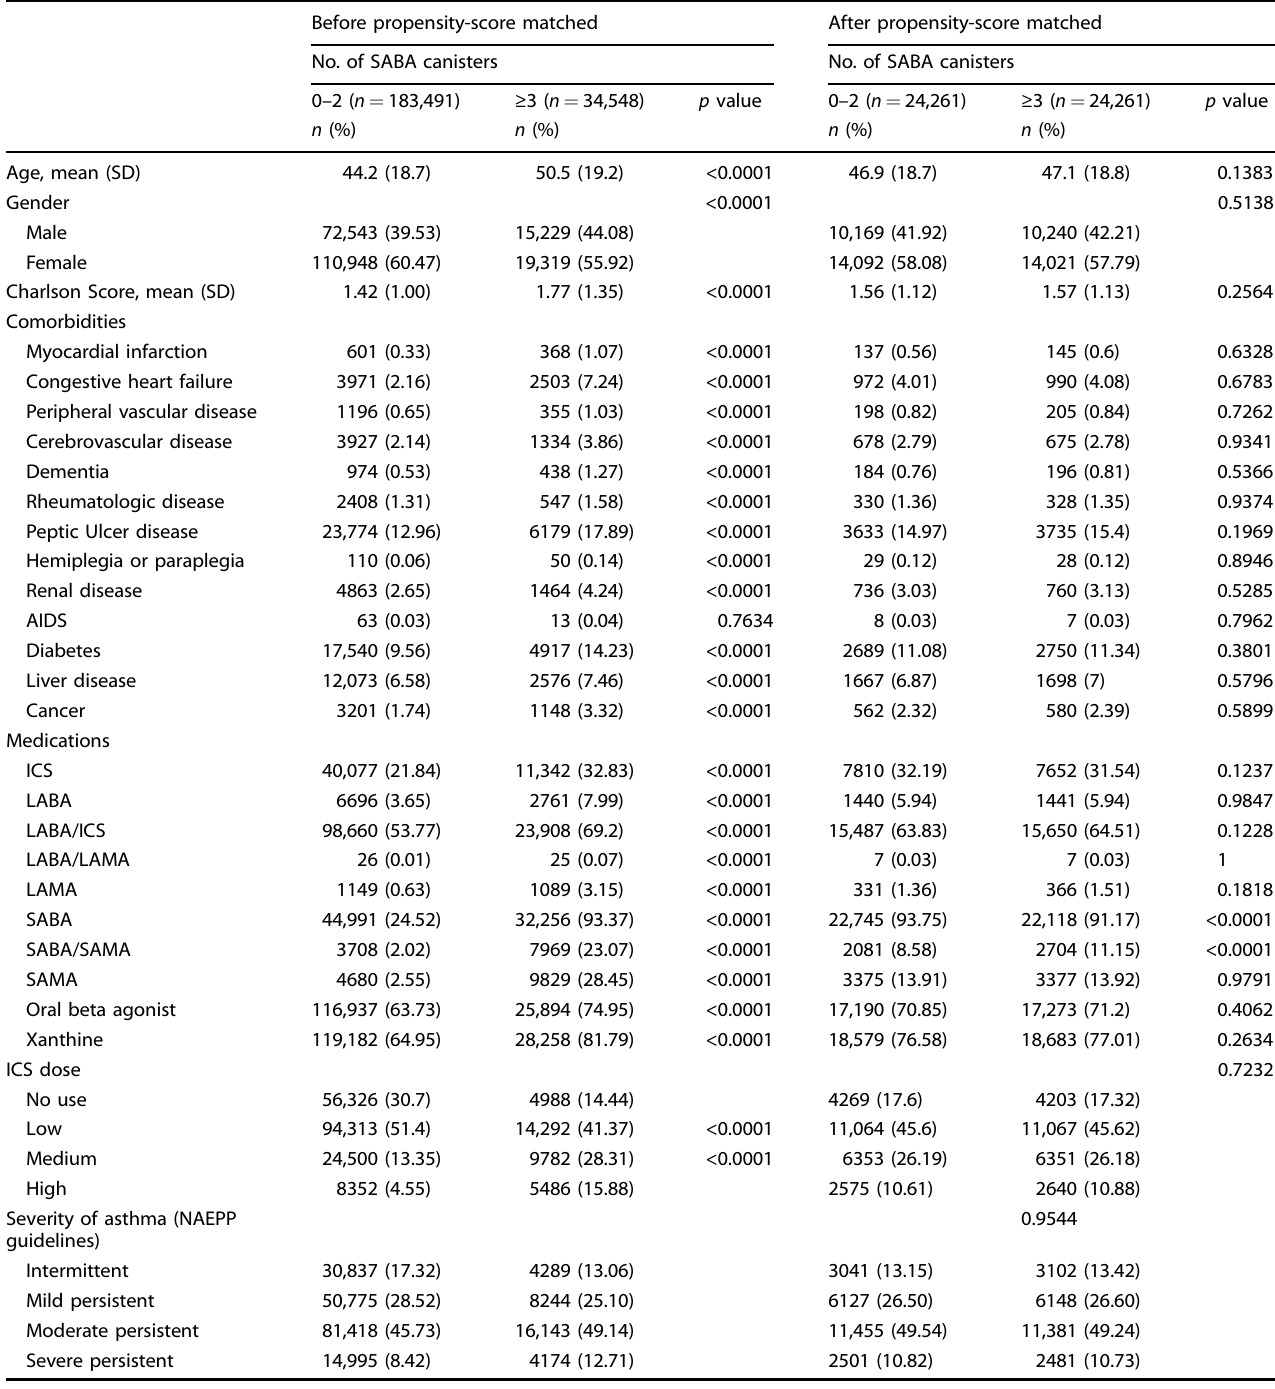
Table 5. Demographic and clinical characteristics of the propensity score-matched population. Before propensity-score matched After propensity-score